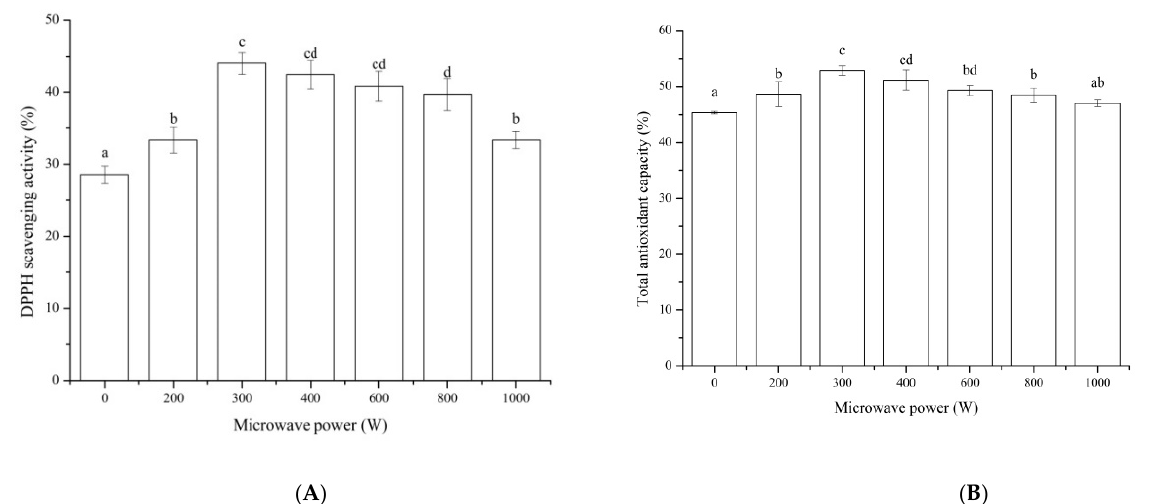
Figure 2. Antioxidant activity: DPPH scavenging activity ( A ) and total antioxidant capacity ( B ) of MP hydrolysate after pretreated by microwave. Results represent the means of three determina- tions±standard deviation. Means with different superscripts (a, b, c, d) are significantly different ( p < 0.05).